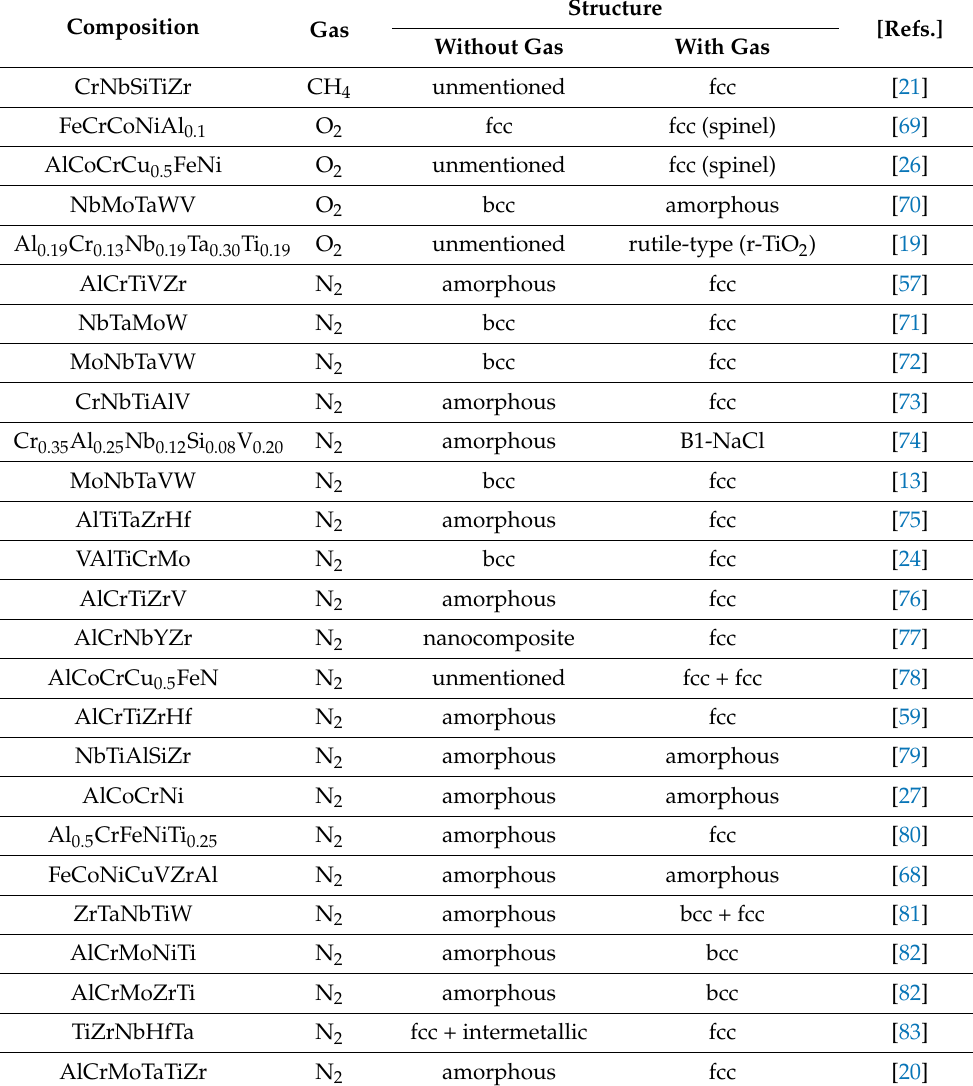
Table 1. Reported crystalline structure of HECF, HEOF and HENF prepared by magnetron sputtering in the last 10